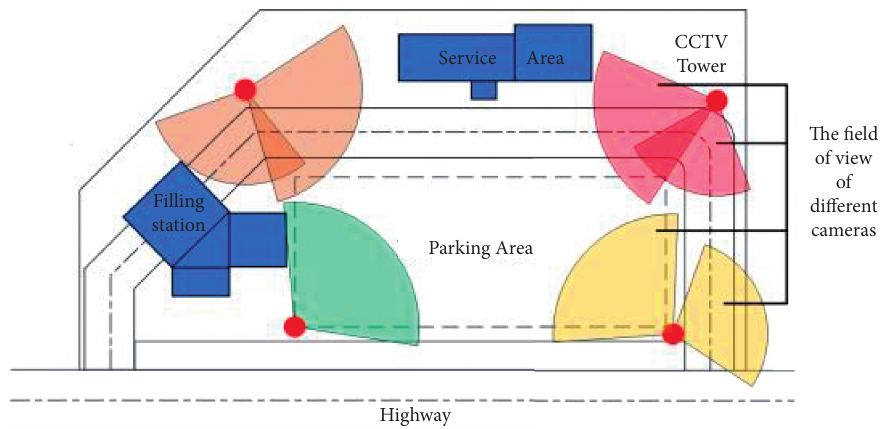
Figure 1: Installation of the CCTV towers in the service station.